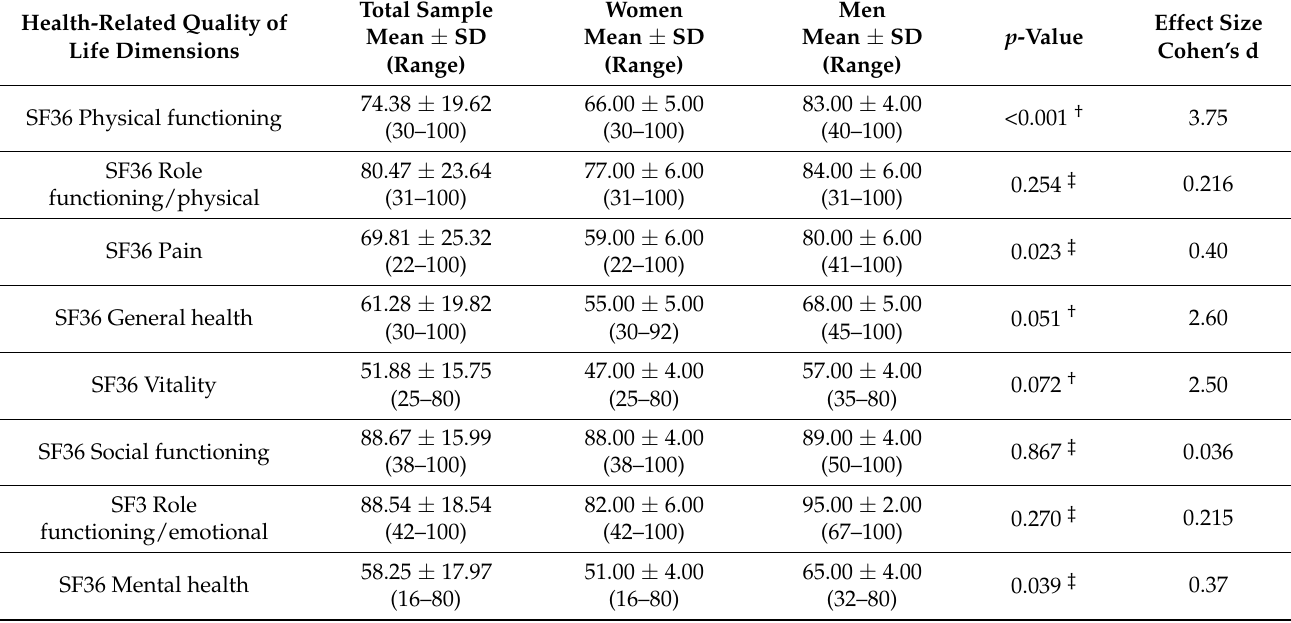
Table 2. Sample SF36 health-related quality of life dimensions.